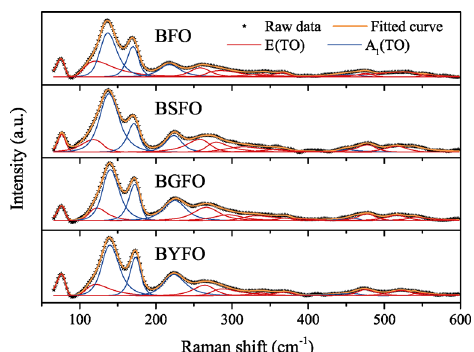
Fig. 3 Deconvoluted Raman spectra of BFO, BSFO, BGFO, and BYFO ceramics.